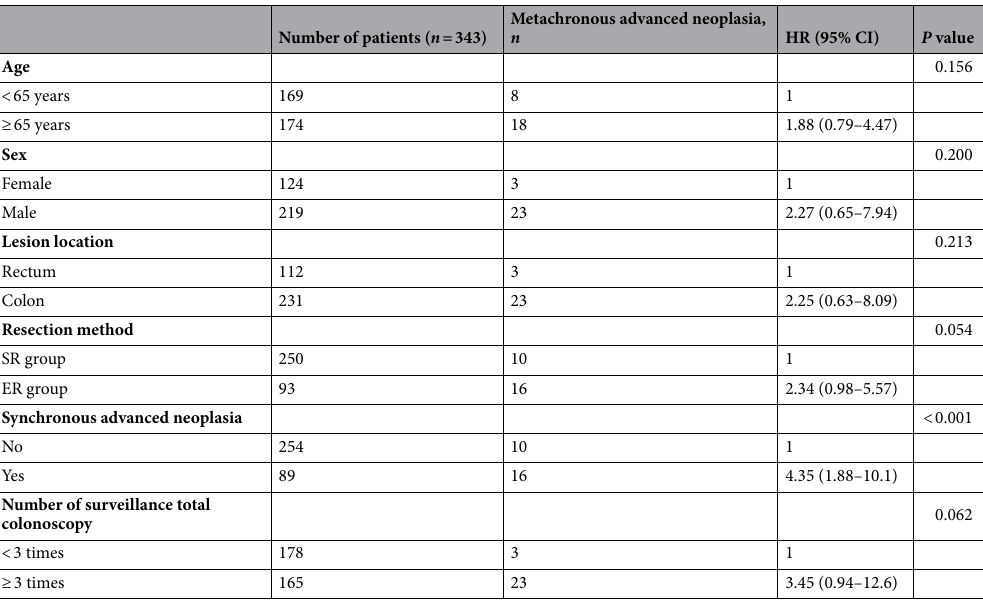
Table 3. Multivariate analysis of risk factors for metachronous advanced neoplasia after resection of submucosal invasive colorectal cancer. CI confidence interval, HR hazard ratio, SR surgical resection, ER endoscopic